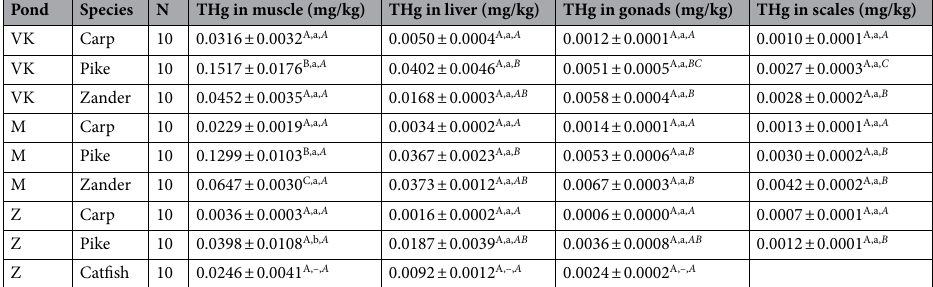
Table 2. Total mercury content THg (mg/kg wet weight; mean ± standard error of mean) in fish tissue of carp, pike, zander and catfish caught in three ponds: Velky Kocelovicky (VK), Mysliv (M) and Zehunsky (Z). Total mercury content in the tissue of different fish species in one pond followed by the same capital letter in the column did not differ significantly (Tuckey post hoc test in factorial ANOVA; separately for VK, M, Z). Total mercury content in the tissue of one species in different ponds followed by the same lower-case letter in the column did not differ significantly (Tuckey post hoc test in factorial ANOVA; separately for carp, pike, zander). Total mercury content in different tissues followed by the same capital letter in italics in the row did not differ significantly (Tuckey post hoc test in factorial ANOVA).